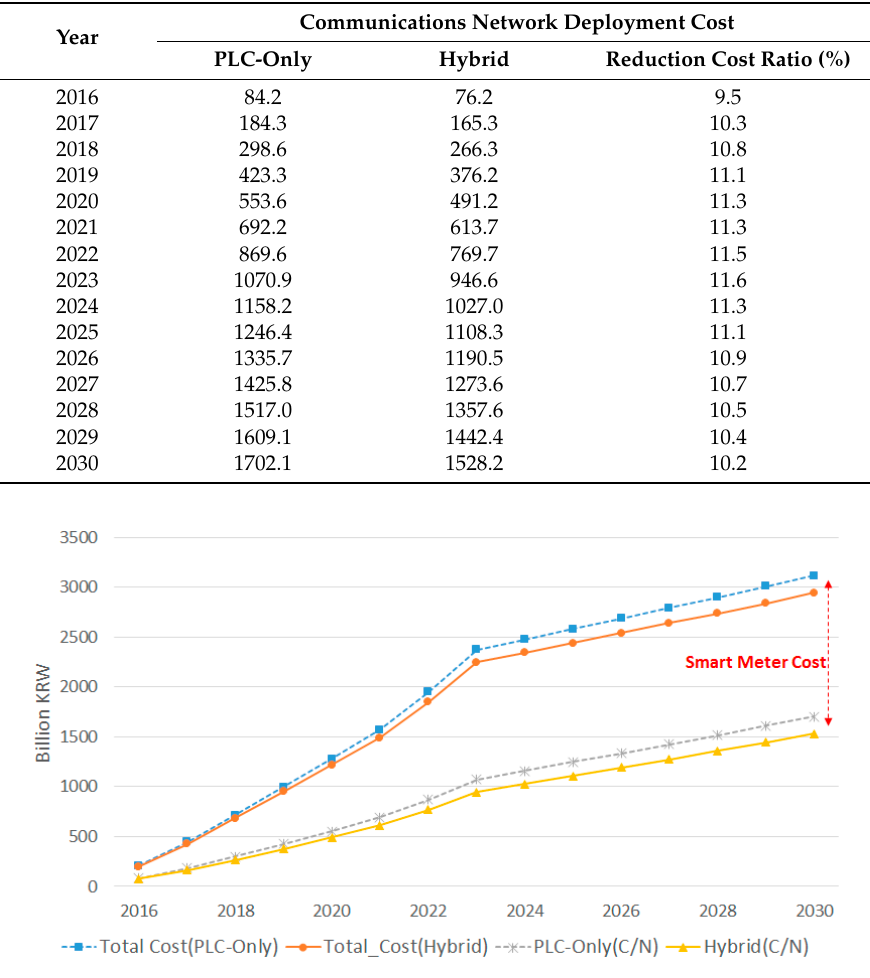
Figure 5. Costs by Deployment Type and Installation Item (C/N: Communication Networks).